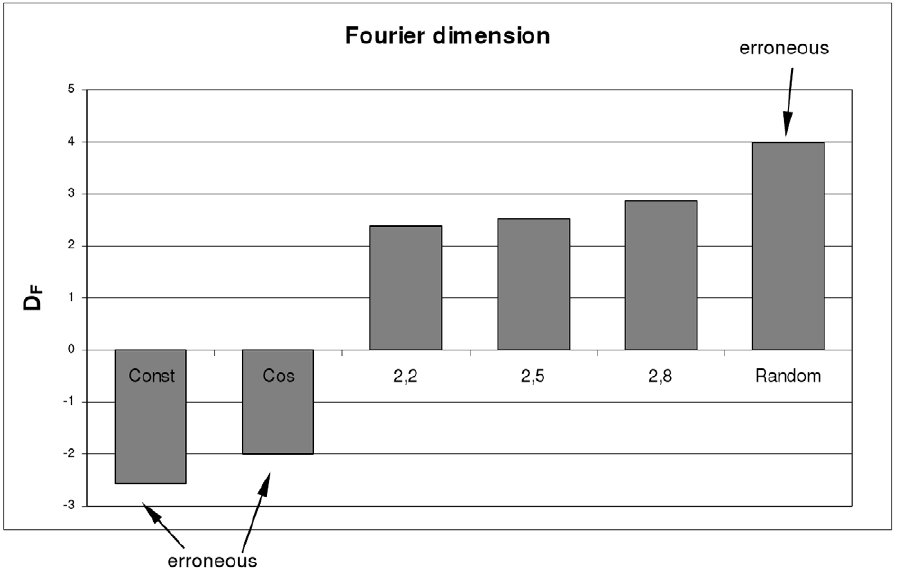
Figure 4. Fourier dimensions of fractal and non-fractal images. Fourier dimensions for an image with a constant gray value, an image with a cosine shaped gray value course in the x-direction, three images with predefined fractal dimensions (D=2.2, 2.5, 2.8) and an image with random gray values. Inaccurate as well as erroneous values are emphasized with arrows.